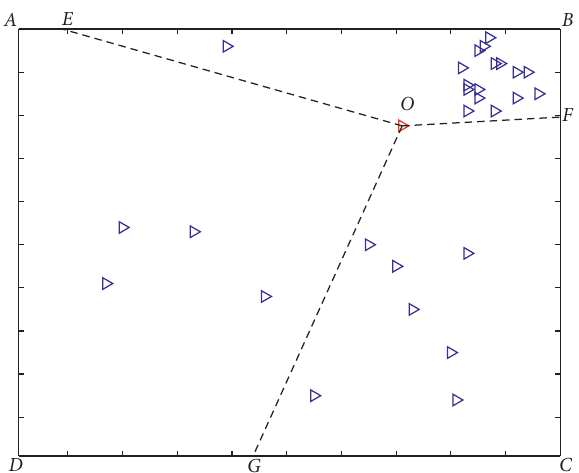
Figure 3: An example demonstrating the advantages of utilizing the proposed method to form territories. The center of mass lies closest to the region populated more densely with available